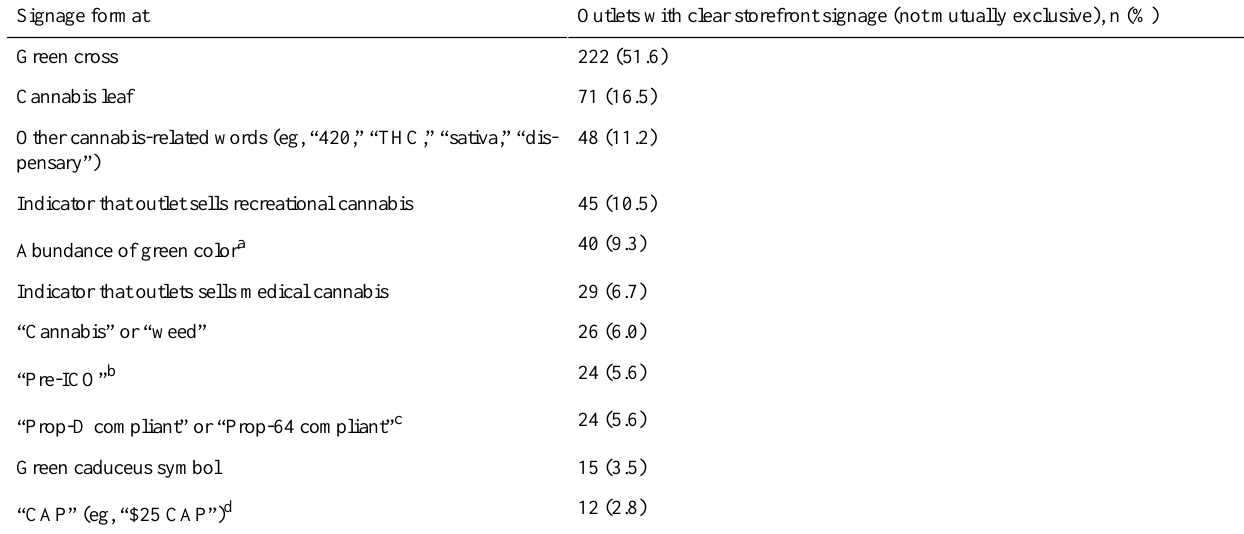
Table 3. Storefront signage for the 430 cannabis